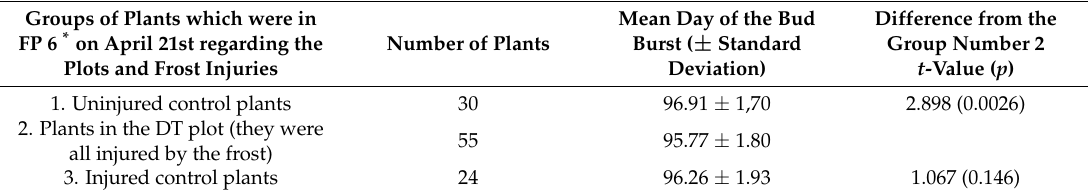
Table 2. Student’s t -test comparing the mean bud burst date between the two groups of control plants (injured or uninjured) and DT plants (all frost